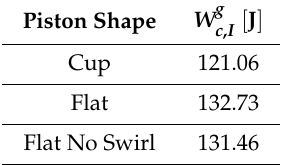
Table 4. Gross indicated work per cycle for the three